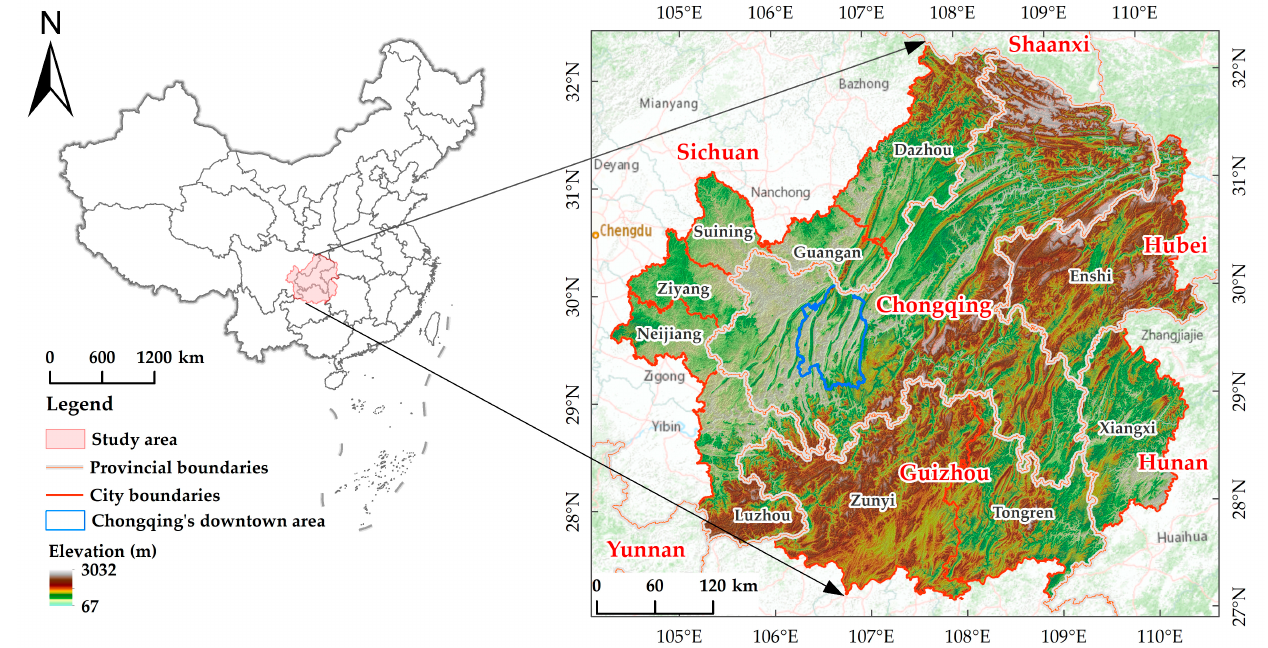
Figure 2. Location of the study